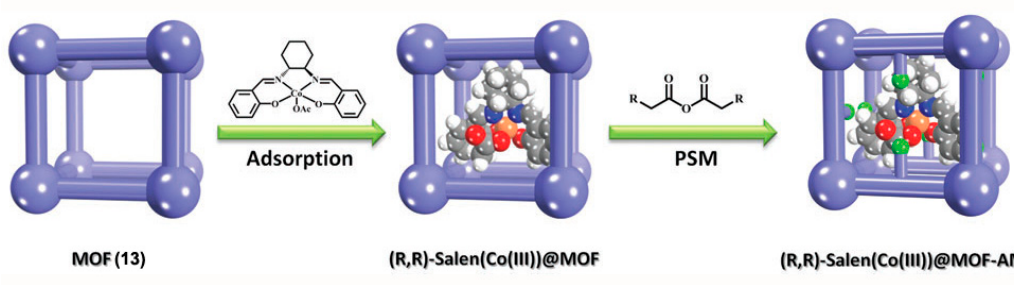
Figure 7. Synthetic method of ( R,R )-salen(Co(III))@IRMOF-3-AM ( 13 ). Reproduced from [71] with permission from the Royal Society of Chemistry.